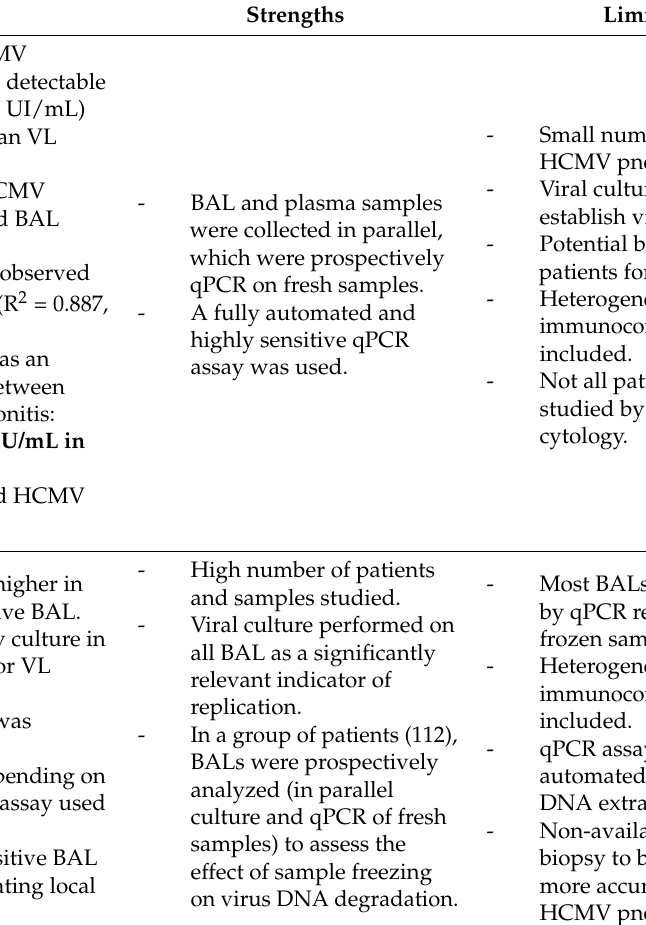
Table 1. Studies on the role of hCMV PCR from BAL in the diagnosis of hCMV pneumonia in immunocompromised patients, in descending chronological order from the date of publication (studies available as of December